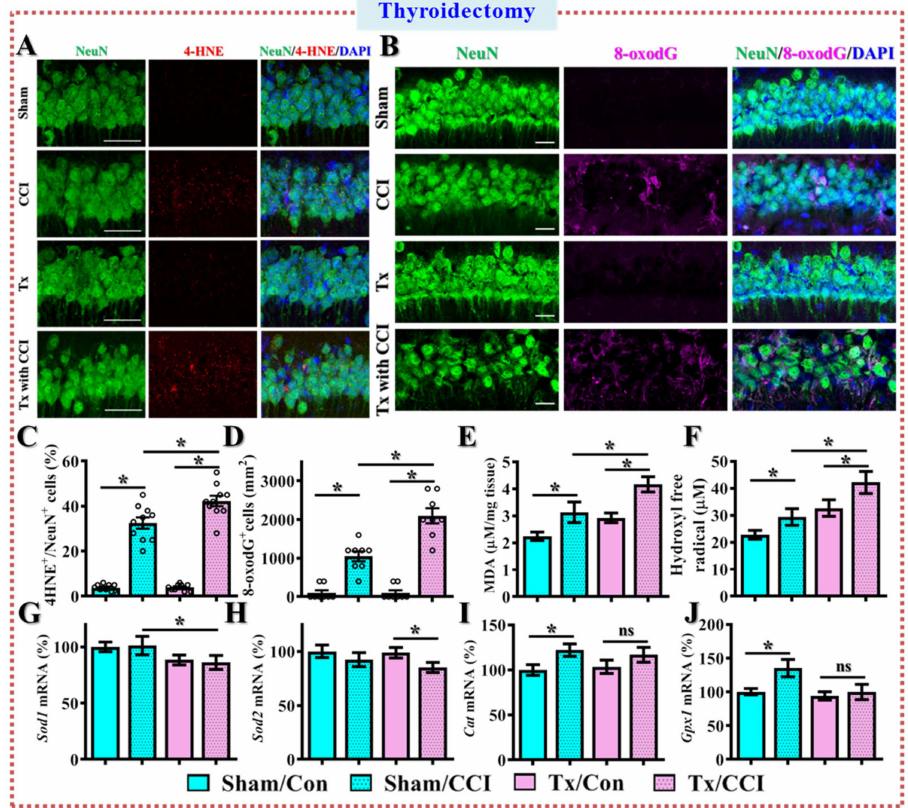
Figure 7. Increase in oxidative stress after CCI in the thyroidectomized animals. ( A ) Representa- tive images of 4-HNE-positive (color in red) neurons (NeuN, color in green) from different ex- perimental groups; ( B ) Representative images of 8-oxodG-positive (color in magenta) neurons (NeuN, color in green). Blue, DAPI signal for the nuclear stain. Scale = 25 µ m; ( C ) Quantifica- tion of the percentage of neurons with 4-HNE-positive puncta; ( D ) Quantification of the regional density of the 8-oxodG-positive neurons. n = 15 images from 5 mice in ( C ) and ( D ); ( E ) Quantification of the levels of Malondialdehyde; ( F ) Quantification of the production of hydroxyl free radicals; ( G – J ) Quantification of the relative expression levels of Sod1 , Sod2 , Cat and Gpx1 mRNAs from different experimental groups with sham-operated or surgical removal of thyroid glands. n = 5 mice. All the data are presented as mean ± SEM and analyzed by a one-way ANOVA with Bonferroni’s post hoc analysis. * p < 0.05; ns, not